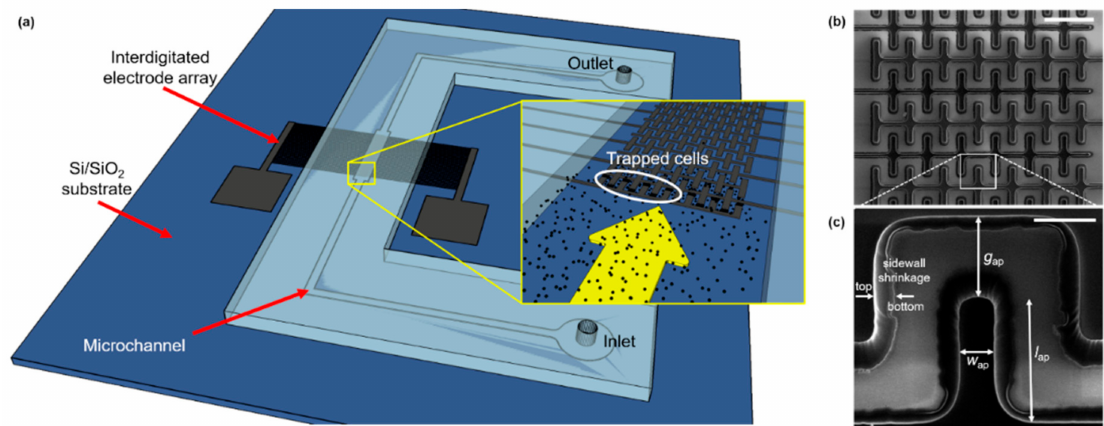
Figure 2. ( a ) Schematic diagram of the Carbon-DEP microfluidic device. The microfluidic channel is connected to inlet and outlet reservoirs, and the Carbon IDEA is powered by an external waveform generator (not shown) across pads. Inset shows a close view of the IDEA with microalgae cells flowing through the microchannel. ( b ) SEM image of the electrode array (scale bar: 100 µ m), and ( c ) close view of the pDEP trapping region (scale bar: 20 µ m). Effective dimensions after pyrolysis (ap) shown in ( b ): gap between opposite electrodes, g ap = 25.45 µ m; width, w ap = 9.91 µ m; length, l ap = 38.15 µ m. Sidewall shrinkage can be noticed along the electrode height from the original SU-8 boundary (bottom) to the final GC edge